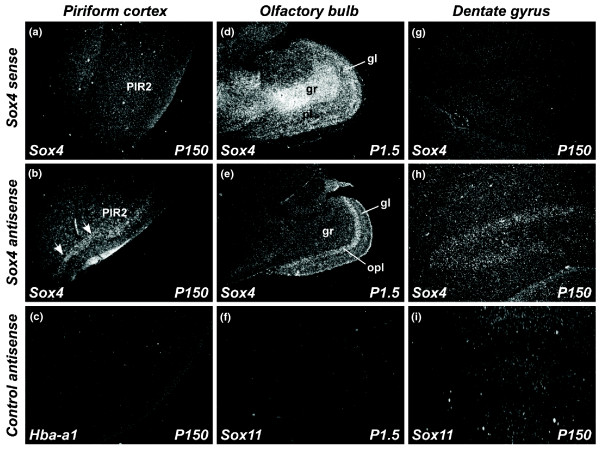
Sox4 antisense expression in other brain regions. (a-i) Sox4 antisense expression is also observed in other regions such as the piriform cortex (a-c; arrows), olfactory bulb (d-f) and dentate gyrus (g-i). (a, d, g) Sox4 sense expression; (b, e, h) Sox4 antisense expression. (c, f, i) Hba-a1 or Sox11 antisense expression (negative controls). All micrographs were taken from sagittal sections except (a-c), which were taken from coronal sections. gl: glomerular layer; gr: granule layer; Opl: outer plexiform layer; PIR2: piriform cortex layer II.